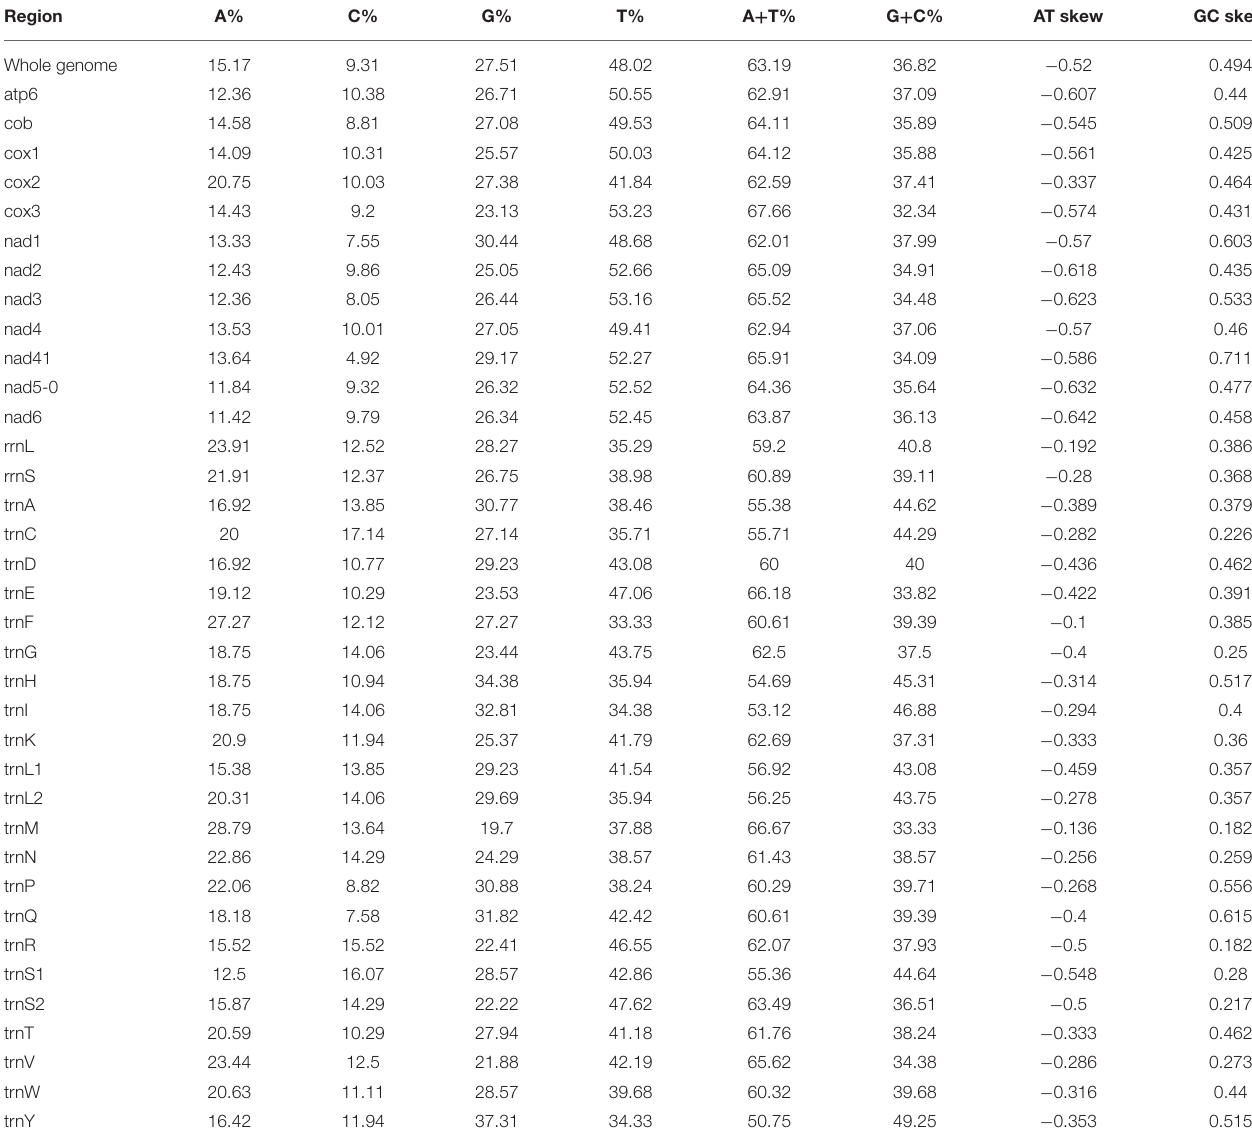
TABLE 3 | Composition and skewness of F. intermediate mitogenome.